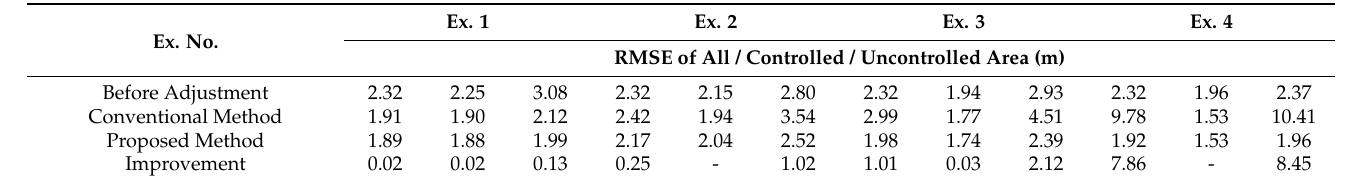
Figure 12. Adjustment results of real data experiment. ( a – d ) show the adjustment results under the different sizes of uncontrolled areas. Red, green, and blue bars represent the RMSEs of the generated DEMs, the traditional method, and the proposed method, respectively. Table 2. RMSEs of real data experiment. The Improvement term represents the improvement in adjustment accuracy when using the proposed method compared to the conventional